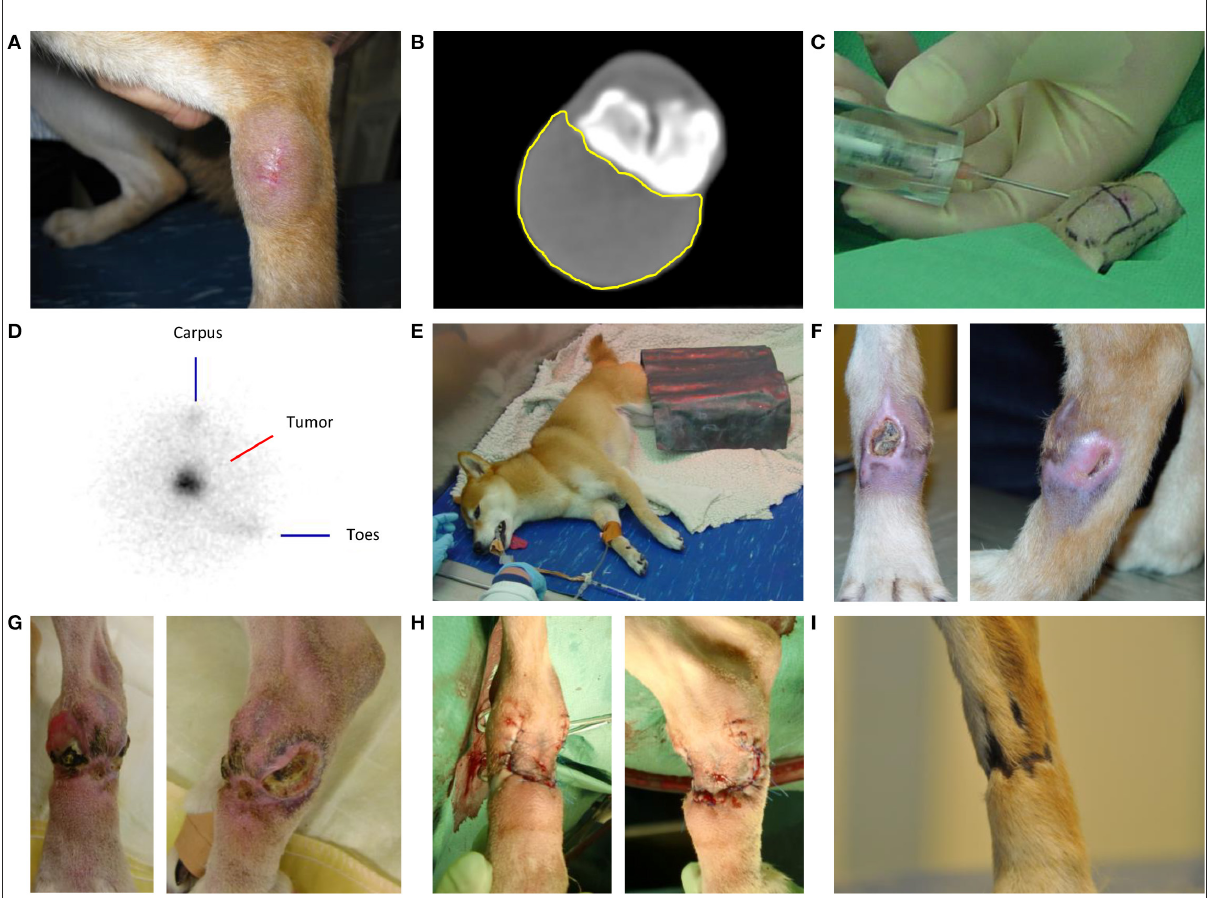
FIGURE1 Intratumoral holmium-166 microsphere ( 166 HoMS) treatment and follow-up of patient 2 with a soft tissue sarcoma in the left dorsal tarsus. (A) The tumor seven days before treatment. (B) Computed Tomography of the tumor five days before treatment, showing the transverse slice with the largest surface area of the tumor (yellow line). (C) Needle-injection of 166 HoMS in four predetermined and marked tumor segments. An 8-mm thick acrylic glass cylinder was placed around the syringe to limit unwanted beta radiation exposure of personnel and the patient. (D) Right lateral planar gamma scintigraphy image of the tumor after treatment, showing concentrated gamma counts in the tumor area (center). (E) Recovery of the patient in our dedicated radionuclide ward. A lead plate was placed over the tumor to limit gamma radiation exposure of personnel. (F) The tumor 29 days after treatment, showing a medial ulceration of ∼ 1.0 × 1.0cm and a lateral ulceration of ∼ 1.0 × 0.5cm. (G) The tumor 93 days after 166 HoMS treatment, showing multiple ulcerations, inflammation, and distal edema formation because of constant licking. (H) The patient’s leg after surgical resection of the tumor, 93 days after 166 HoMS treatment. (I) The patient’s leg 281 days after 166 HoMS treatment and 188 days after surgical resection, showing dark and hairless scar tissue at the location of the resected